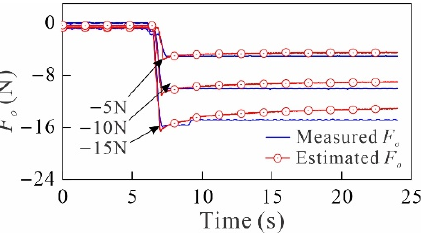
Figure 9. The comparison of the actuating force F 0 obtained from Equation (8) and force gauge. Table 1. External force estimation and force control performance of the LSEA system.